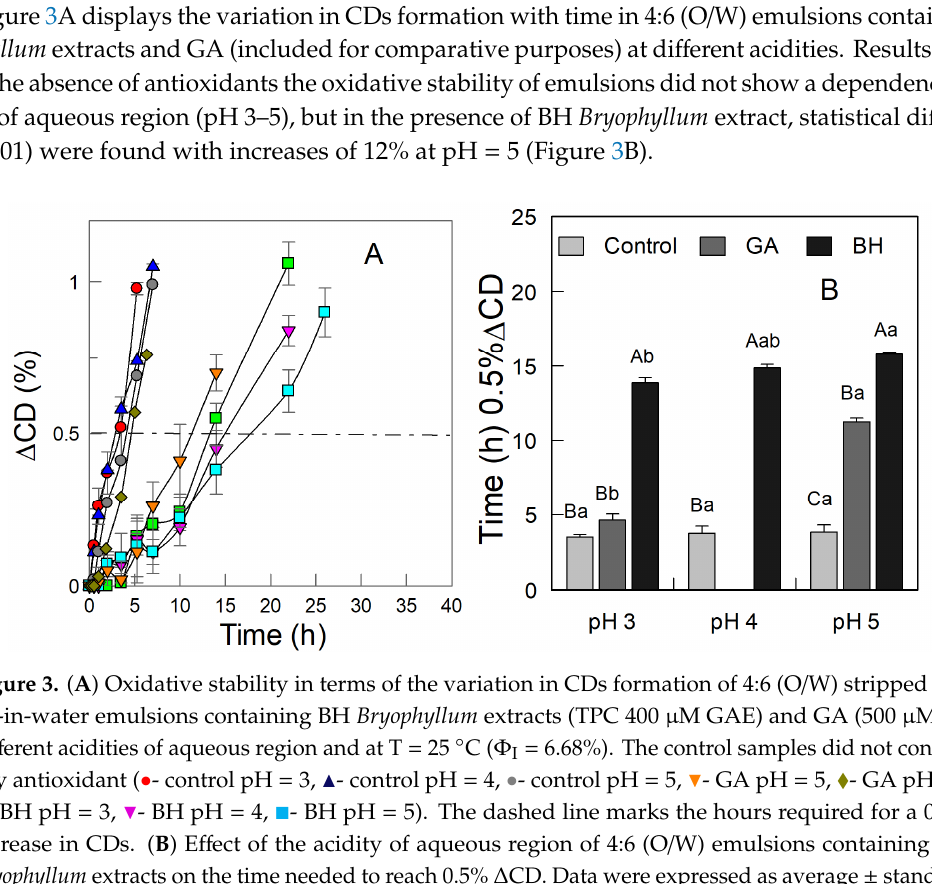
Figure 4. (A) Oxidative stability in terms of the variation in CDs formation of 4:6 (O/W) stripped fish oil-in-water emulsions containing BH Bryophyllum extracts (TPC 500  M GAE) at different temperatures (  I = 6.68%, pH = 3.0, 0 rpm). The dashed line marks the hours required for a 0.5% CDs increase. (B) Effect of the temperature (10 °C–30 °C) in 4:6 (O/W) emulsions containing BH Bryophyllum extracts on the time needed to reach 0.5%  CD. Data were expressed as average ± standard deviation and different letters indicate significant differences (  = 0.001).